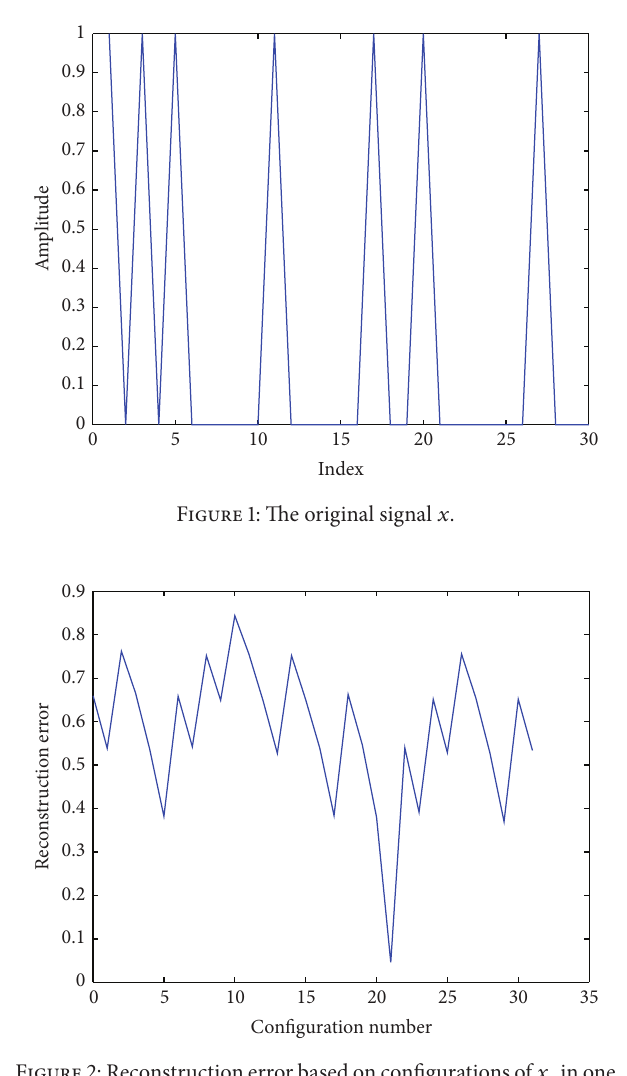
Figure 4: Average reconstruction error based on configurations of 𝑥 𝑐